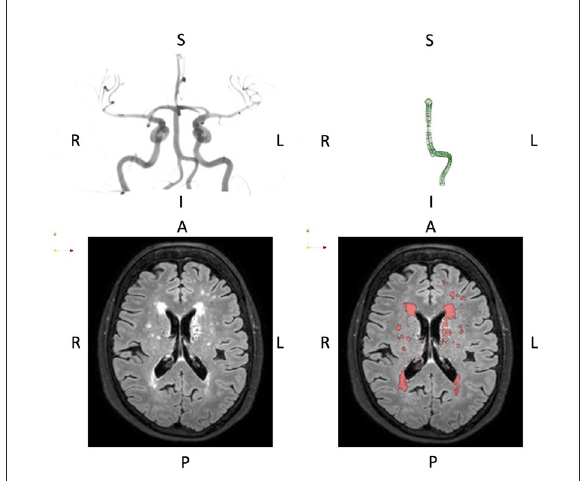
FIGURE1 Typical presentation of basilar artery geometry (top row) and WMH burden (bottom row). The basilar artery segmentation is the full P1-P4 segment thus including the dominant vertebral artery segment. The orientation is indicated by the letters A, Anterior; P, Posterior; L, Left; R, Right; I, Inferior; S,